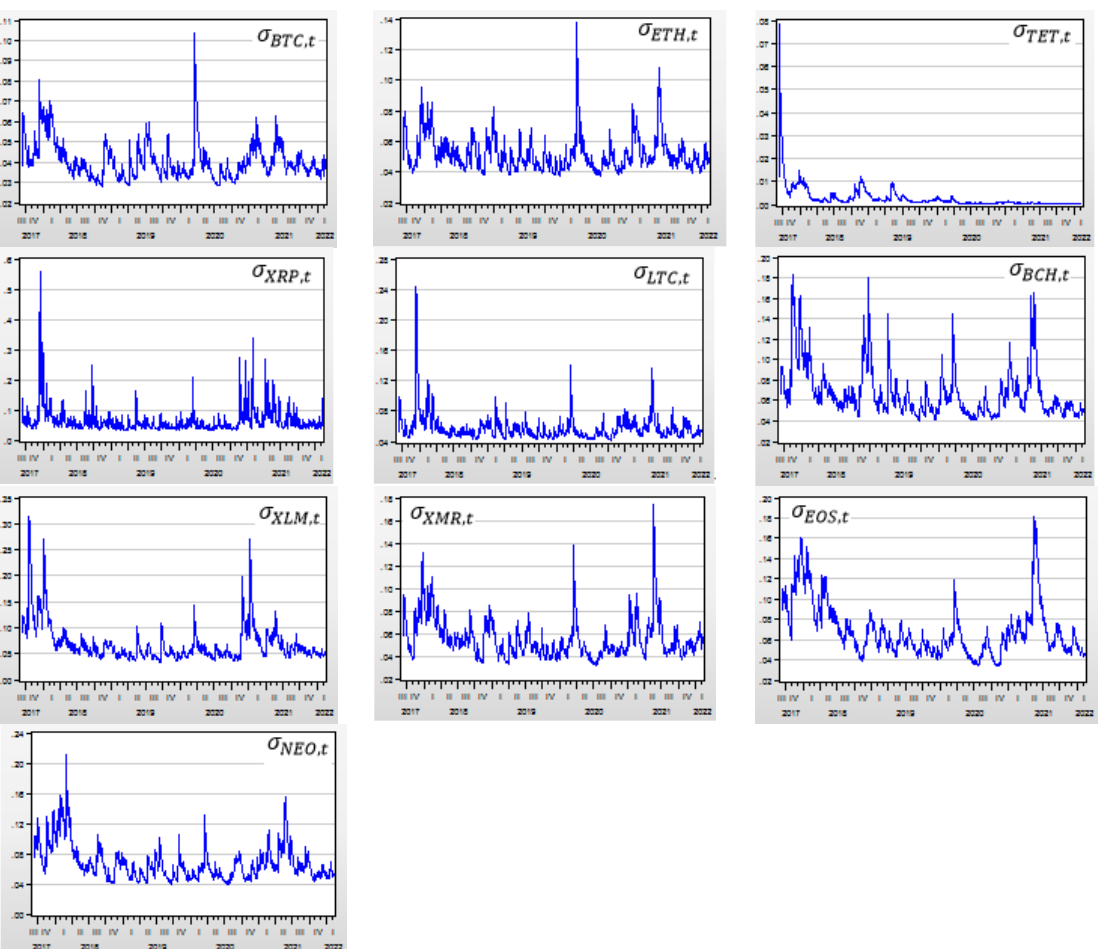
Figure 2. Curves of GARCH values from the 10 cryptocurrencies’ return indices for the full period